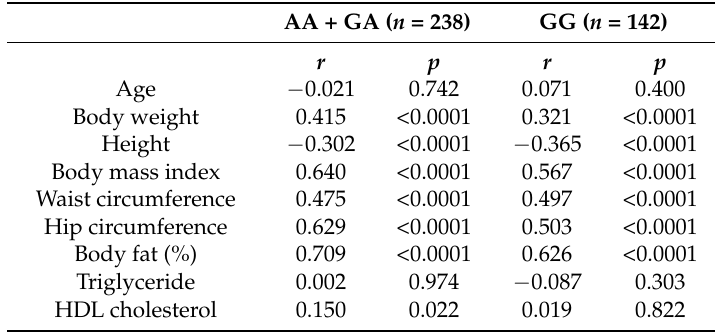
Table 2. Correlation between leptin and adiposity within UCP2 genotypes.